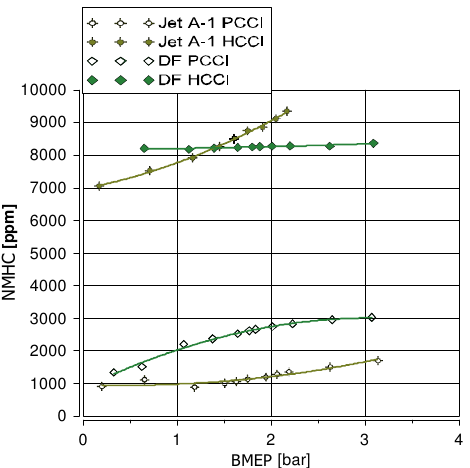
Fig. 9. Emission of non-methane hydrocarbons (NMHC) vs. BMEP for four modes of